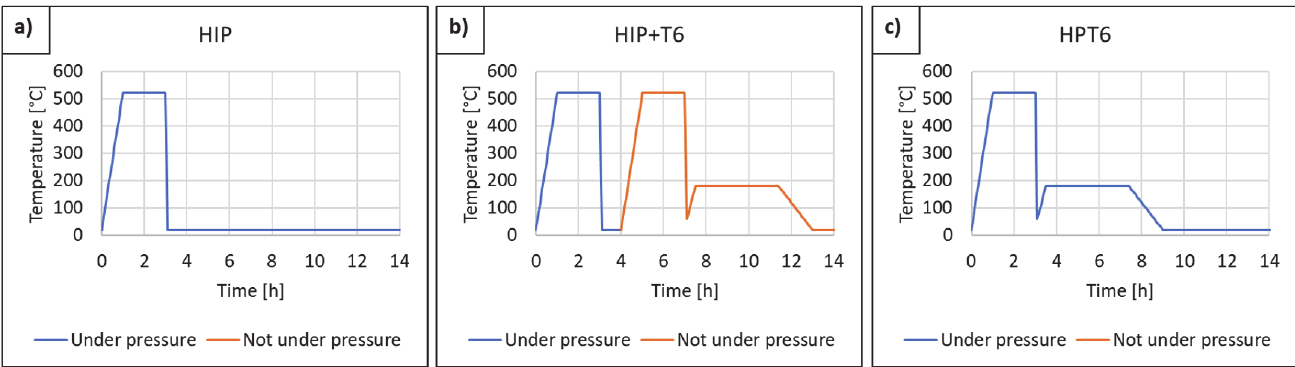
Figure 1: Temperature-time correlation for the 3 different types of treatment: (a) hot isostatic pressing (HIP); (b) hot isostatic pressing and T6 heat treatment at atmospheric pressure (HIP+T6); (c) innovative under pressure T6 heat treatment